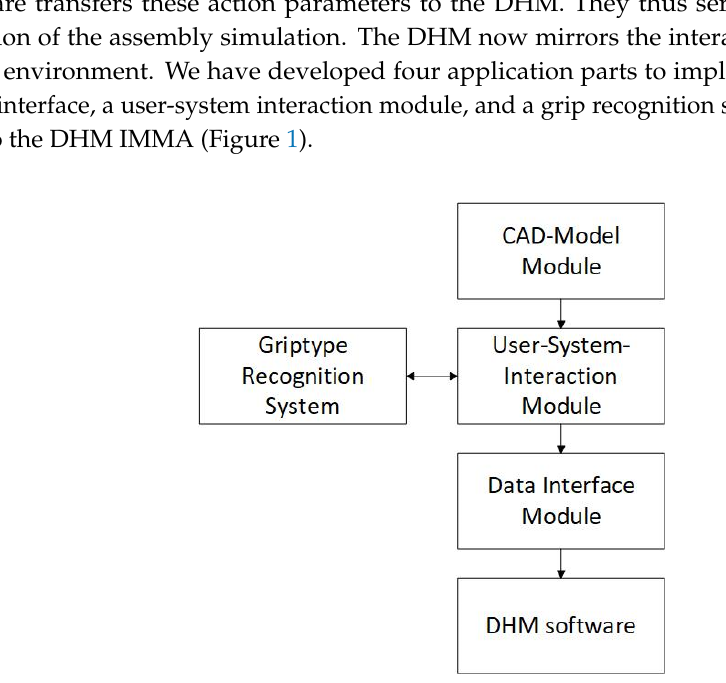
Figure 1. Virtual action tracking system architecture.